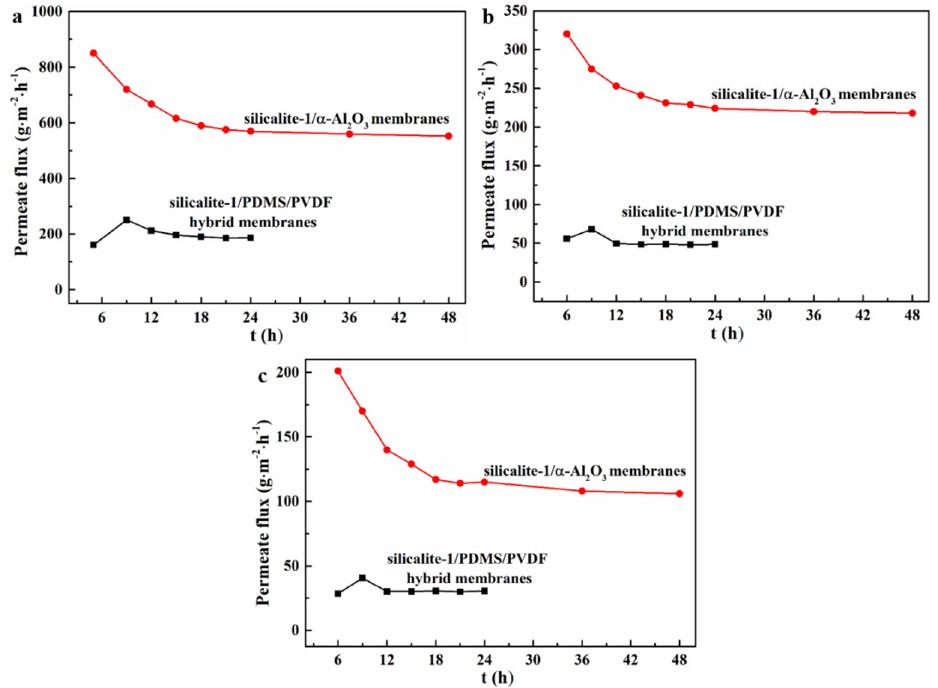
Figure 10. Pervaration flux results of the silicalite-1/ α− Al 2 O 3 membranes [3] and the silicalite- 1/PDMS/PVDF hybrid membranes in single − isomer solutions: ( a ) p − DCB; ( b ) o − DCB; and ( c ) m − DCB.